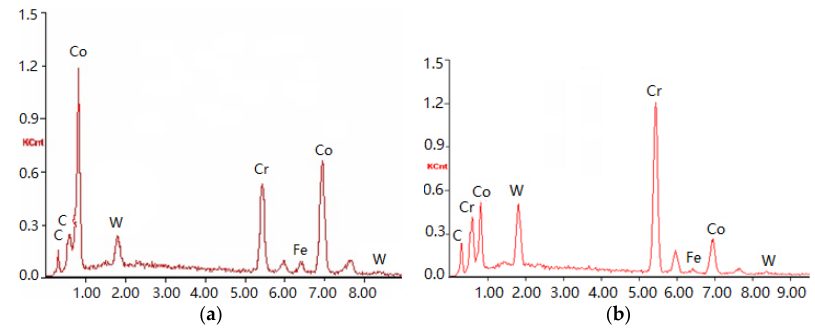
Figure 5. Presence of atomic elements by EDS in ( a ) Area a, and ( b ) Area b.